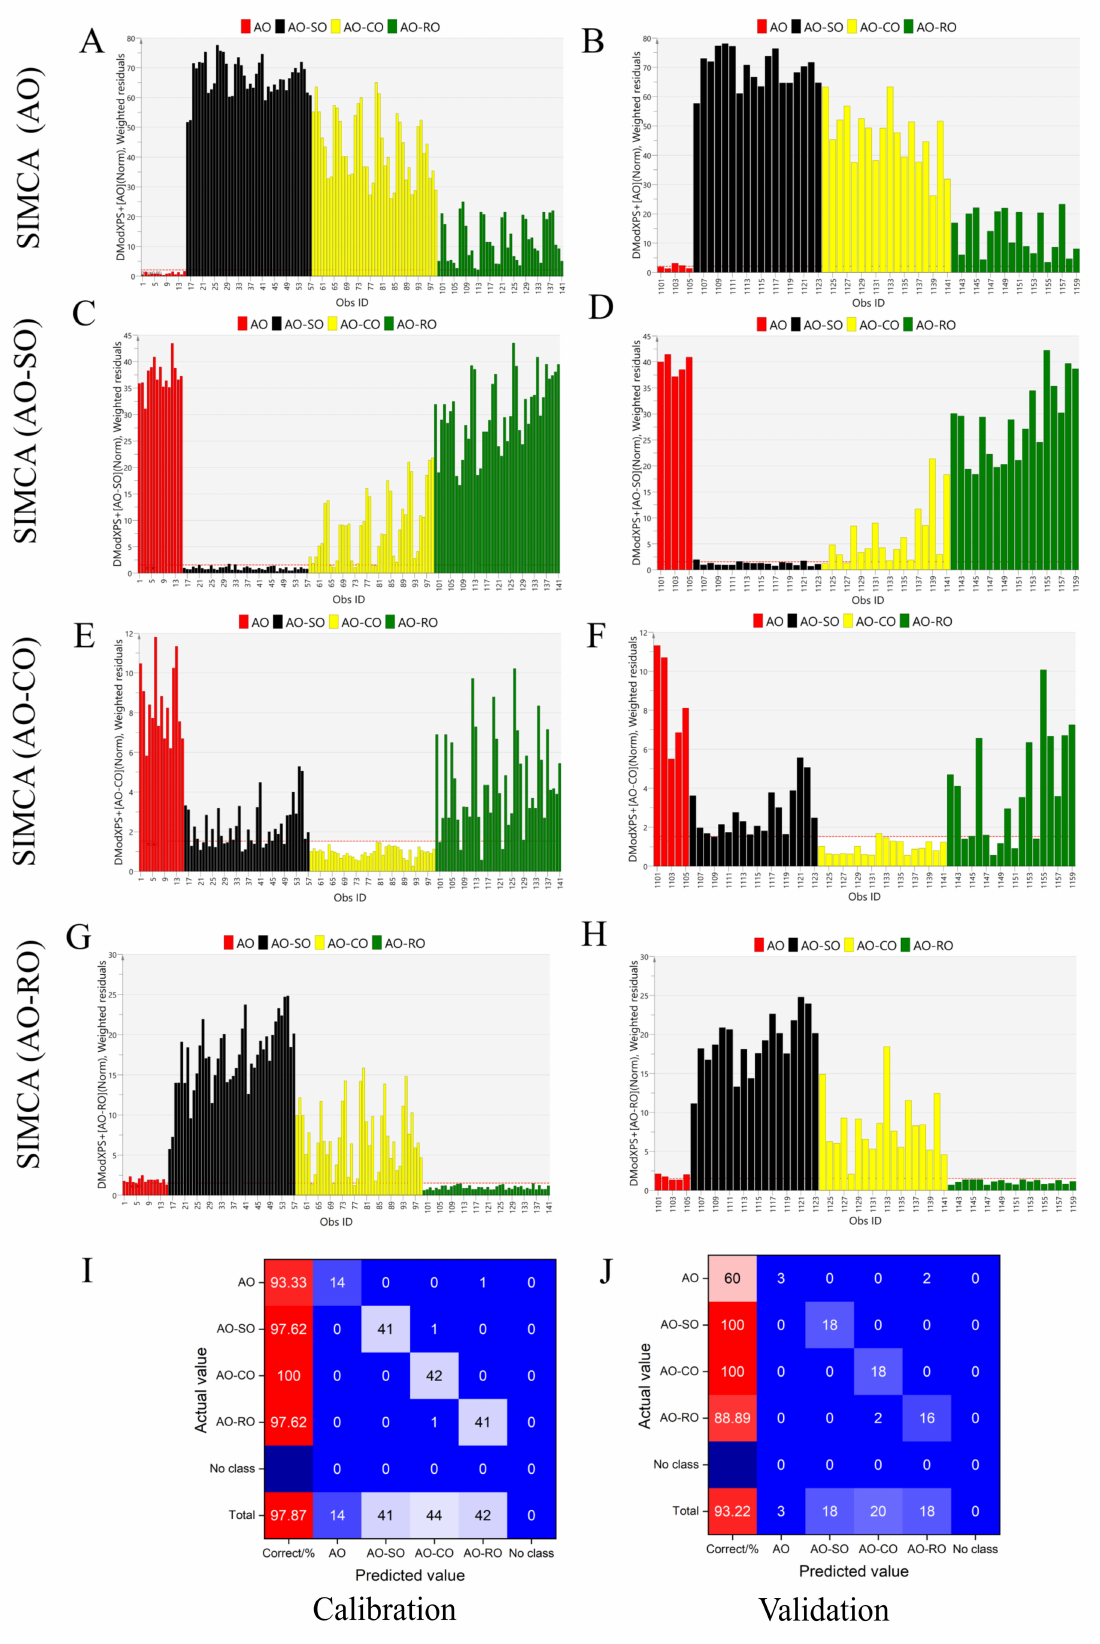
Figure 3. SIMCA analysis to distinguish pure AO from adulterated AO: The DModXPS+ diagram of pure AO ( A , B ), AO-SO ( C , D ), AO-CO ( E , F ) and AO-RO ( G , H ); the samples on the left ( A , C , E , G ) were used for calibration and the samples on the right ( B , D , F , H ) were used for validation; ( I , J ) show the specific discrimination results of calibration ( I ) and validation ( J ) in the form of confusion